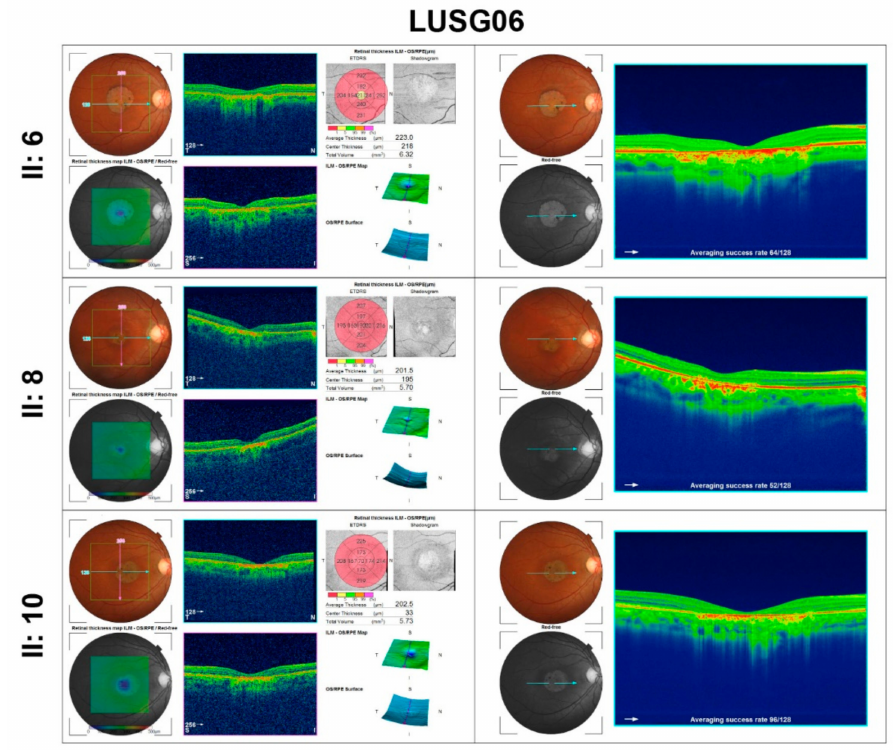
Figure 4. Optical Coherence Tomography (OCT) images of macula of family LUSG06 along with retinal